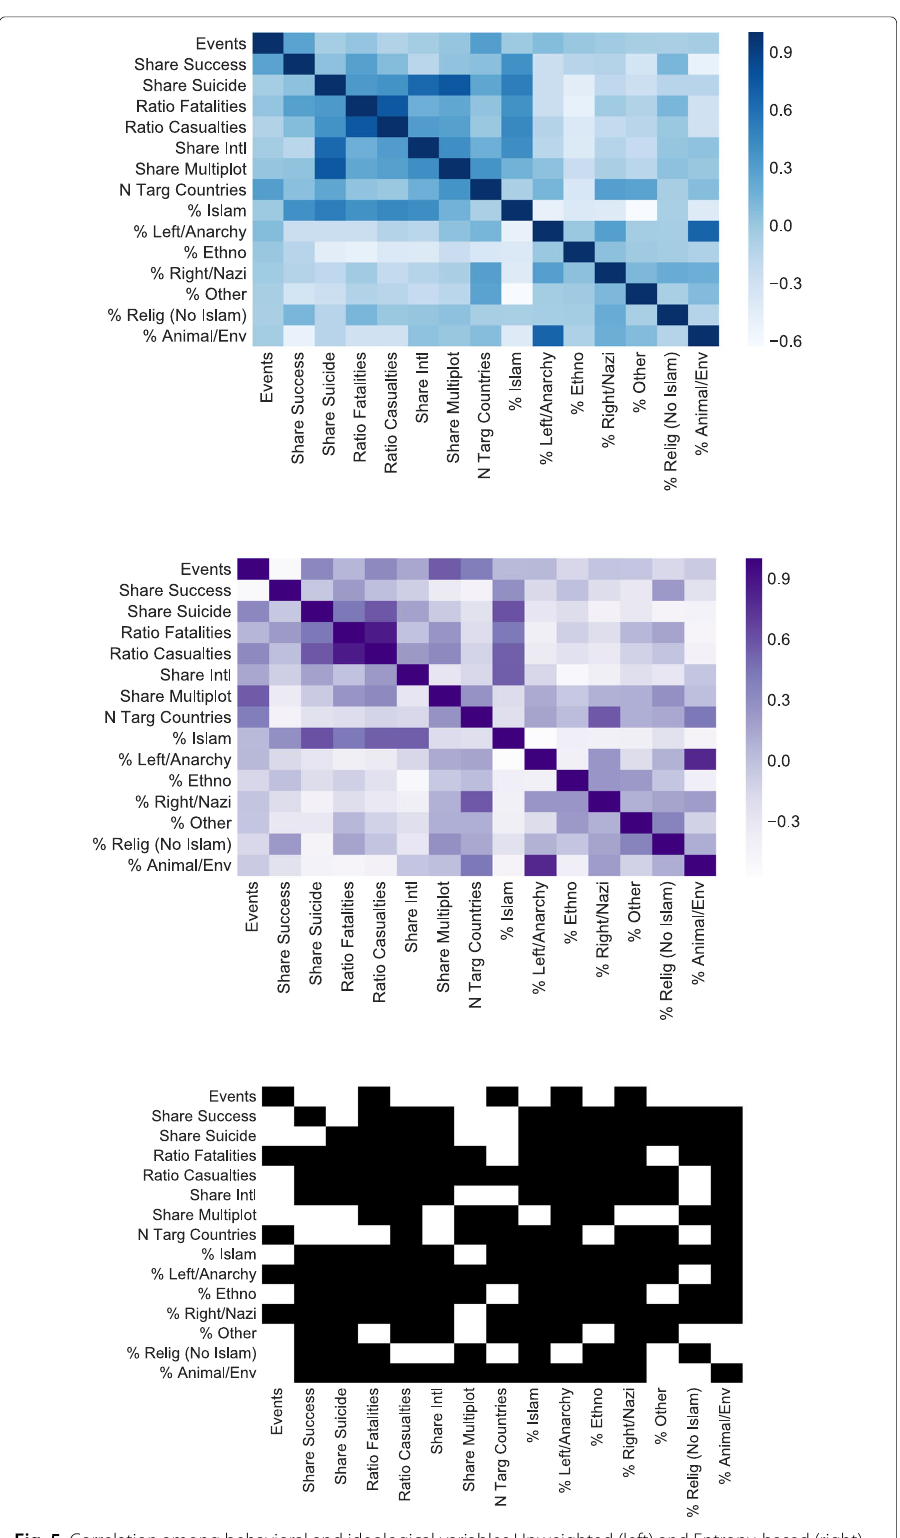
Fig. 5 Correlation among behavioral and ideological variables Unweighted (left) and Entropy-based (right) approaches. Correlation shows what bivariate relations stay stable across both approaches (namely, they maintain the same direction). Bottom plot highlights (in black) stable relations against non-stable